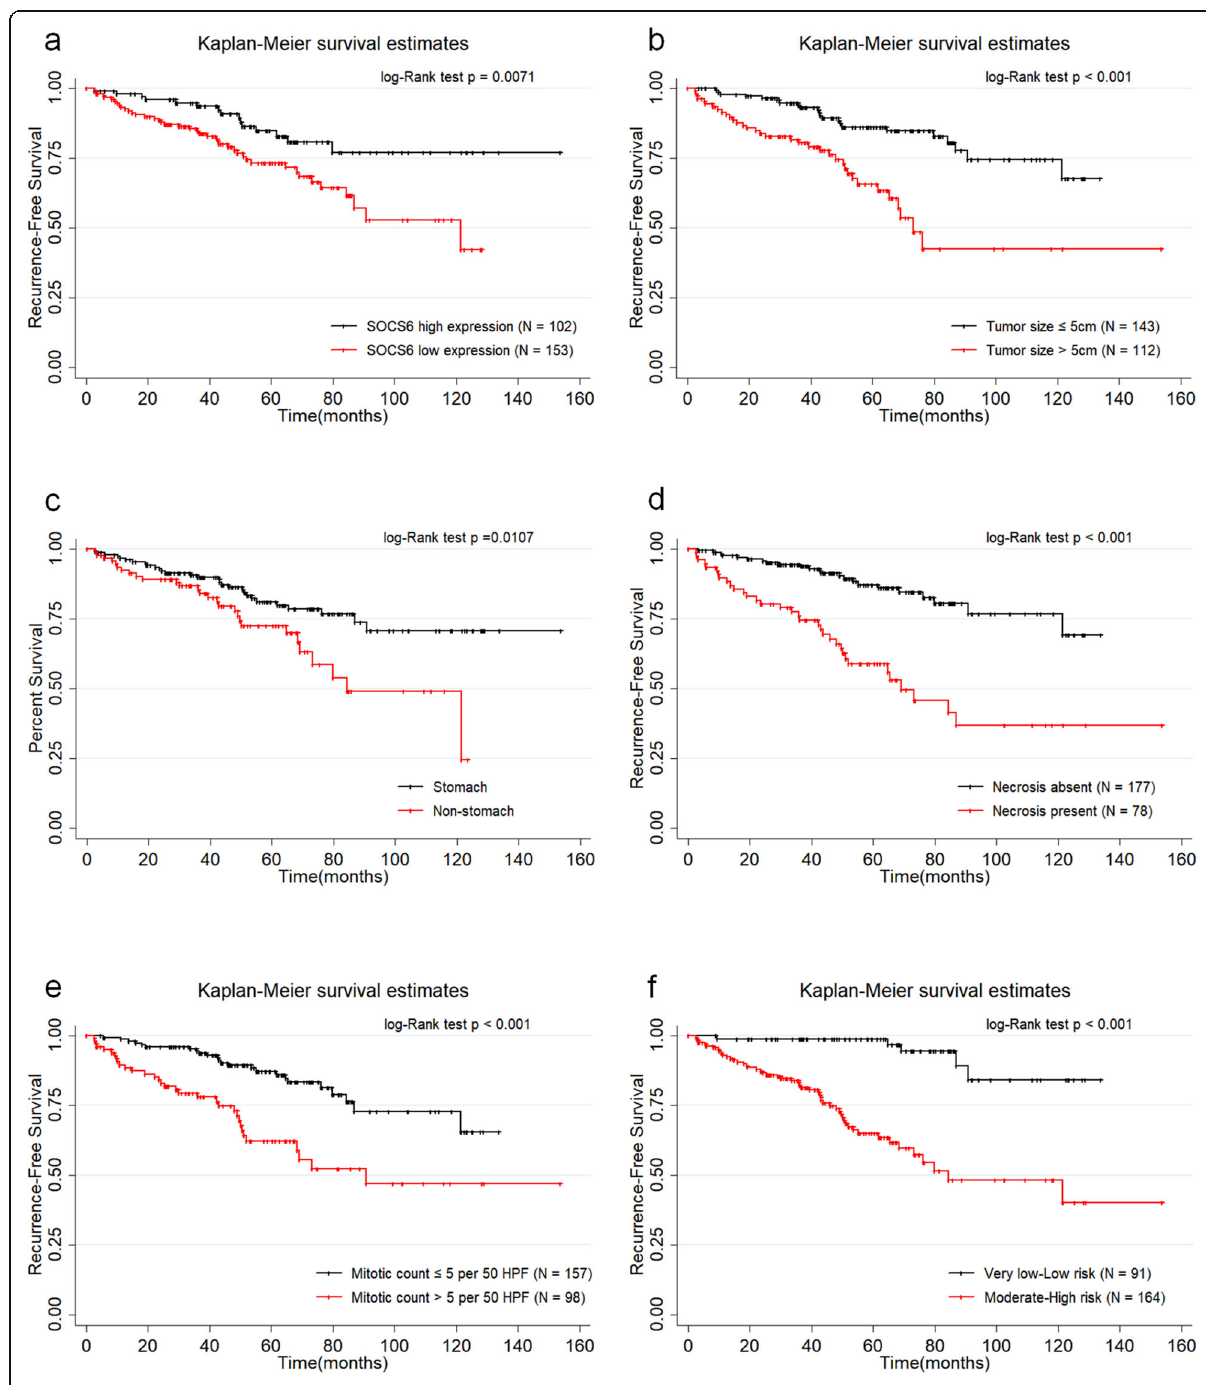
Fig. 4 The impacts of SOCS expression, tumor size, necrosis of tumor, mitotic index, NIH risk grade on RFS assessed according to Kaplan-Meier curve analysis and log-rank test. A Impact of SOCS6 expression on RFS of GIST patients. B The impact of tumor size on RFS of GIST patients. C The impact of tumor location on RFS of GIST patients. D The impact of necrosis of tumor on RFS of GIST patients. E The impact of mitotic index on RFS of GIST patients. F The impact of NIH risk grade on RFS of GIST